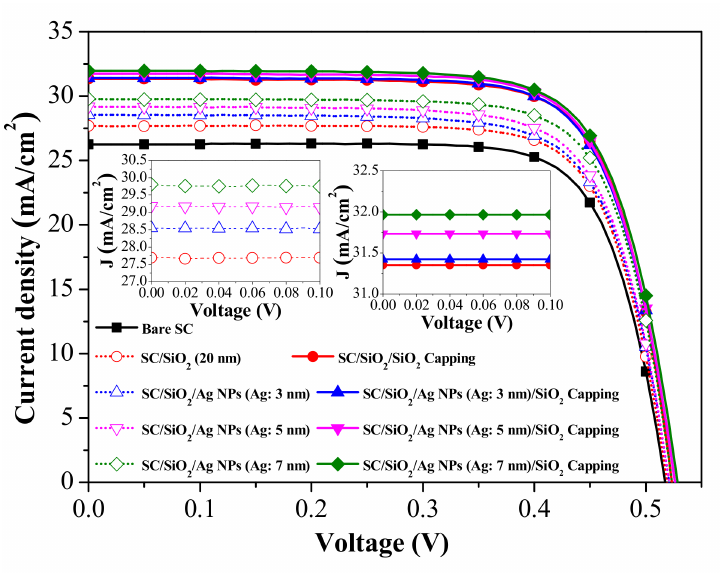
Figure 6. Photovoltaic J-V curves of all evaluated solar